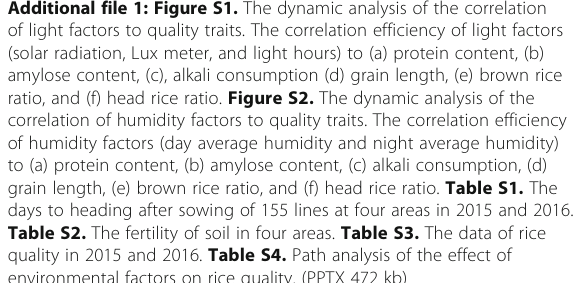
Additional file 1: Figure S1. The dynamic analysis of the correlation of light factors to quality traits. The correlation efficiency of light factors (solar radiation, Lux meter, and light hours) to (a) protein content, (b) amylose content, (c), alkali consumption (d) grain length, (e) brown rice ratio, and (f) head rice ratio. Figure S2. The dynamic analysis of the correlation of humidity factors to quality traits. The correlation efficiency of humidity factors (day average humidity and night average humidity) to (a) protein content, (b) amylose content, (c) alkali consumption, (d) grain length, (e) brown rice ratio, and (f) head rice ratio. Table S1. The days to heading after sowing of 155 lines at four areas in 2015 and 2016. Table S2. The fertility of soil in four areas. Table S3. The data of rice quality in 2015 and 2016. Table S4. Path analysis of the effect of environmental factors on rice quality. (PPTX 472